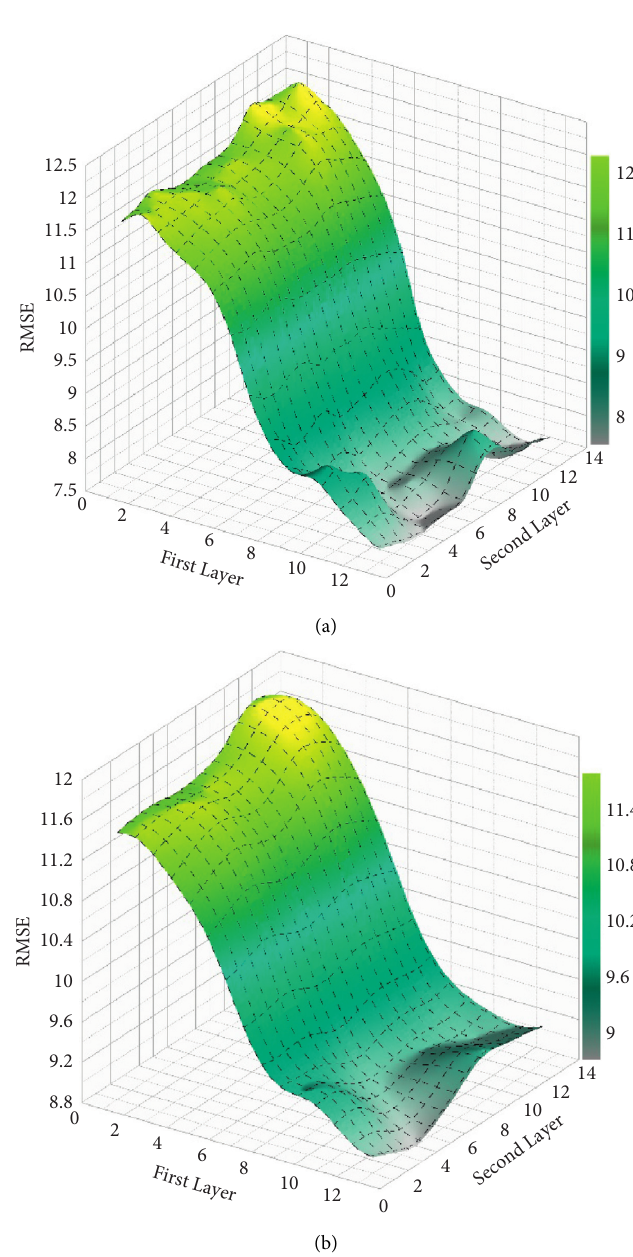
Figure 5: RMSE values for the two-hidden-layer ANN for (a) training data and (b) testing